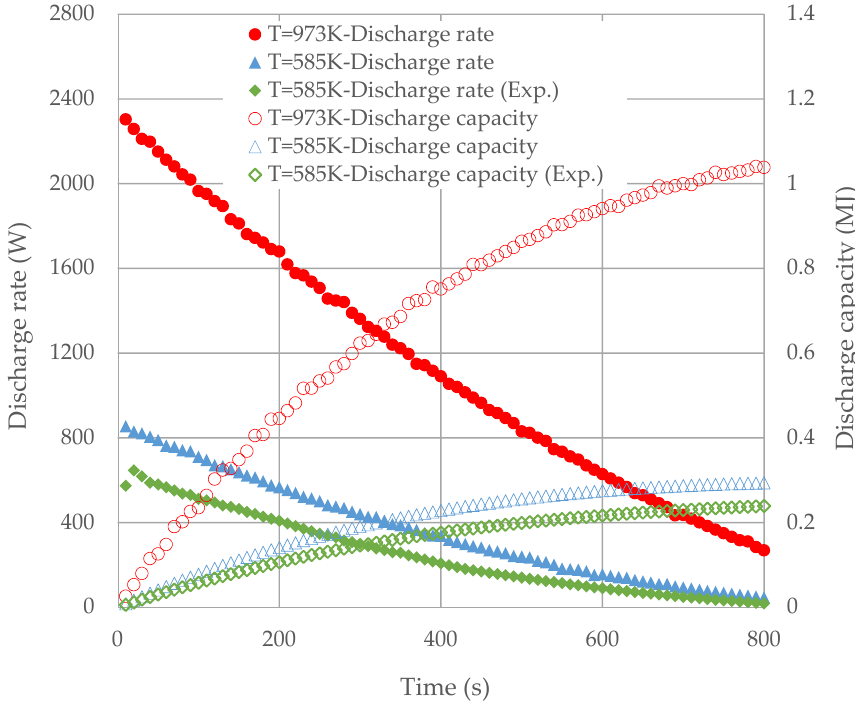
Figure 10. The variations in discharge rate and discharge capacity over time.